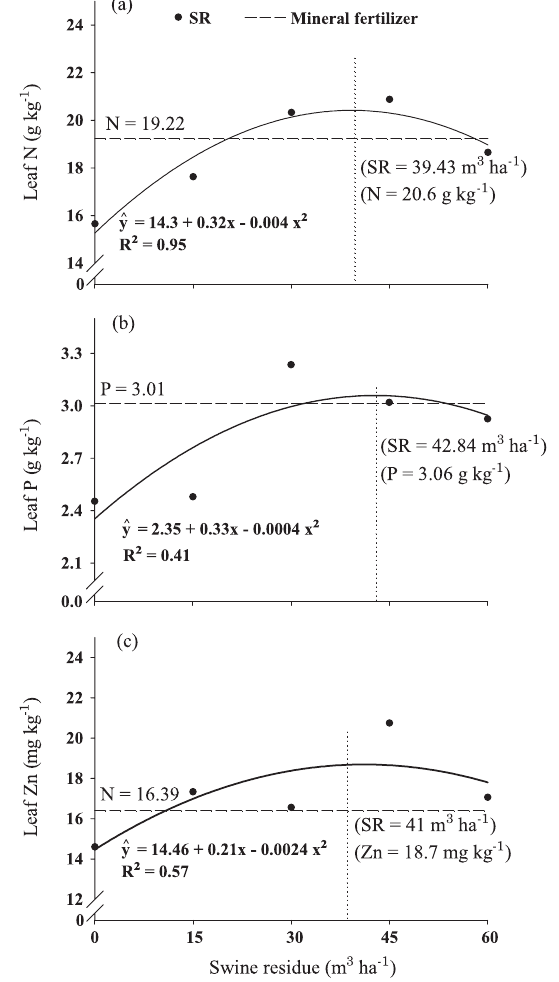
figure 2. concentration of n (a), P (b) and Zn (c) in maize leaves as affected by SR rates and mineral fertilizer in the growing season 2006/2007. Values in correspond parentheses to the rate of SR for maximun content of the respective